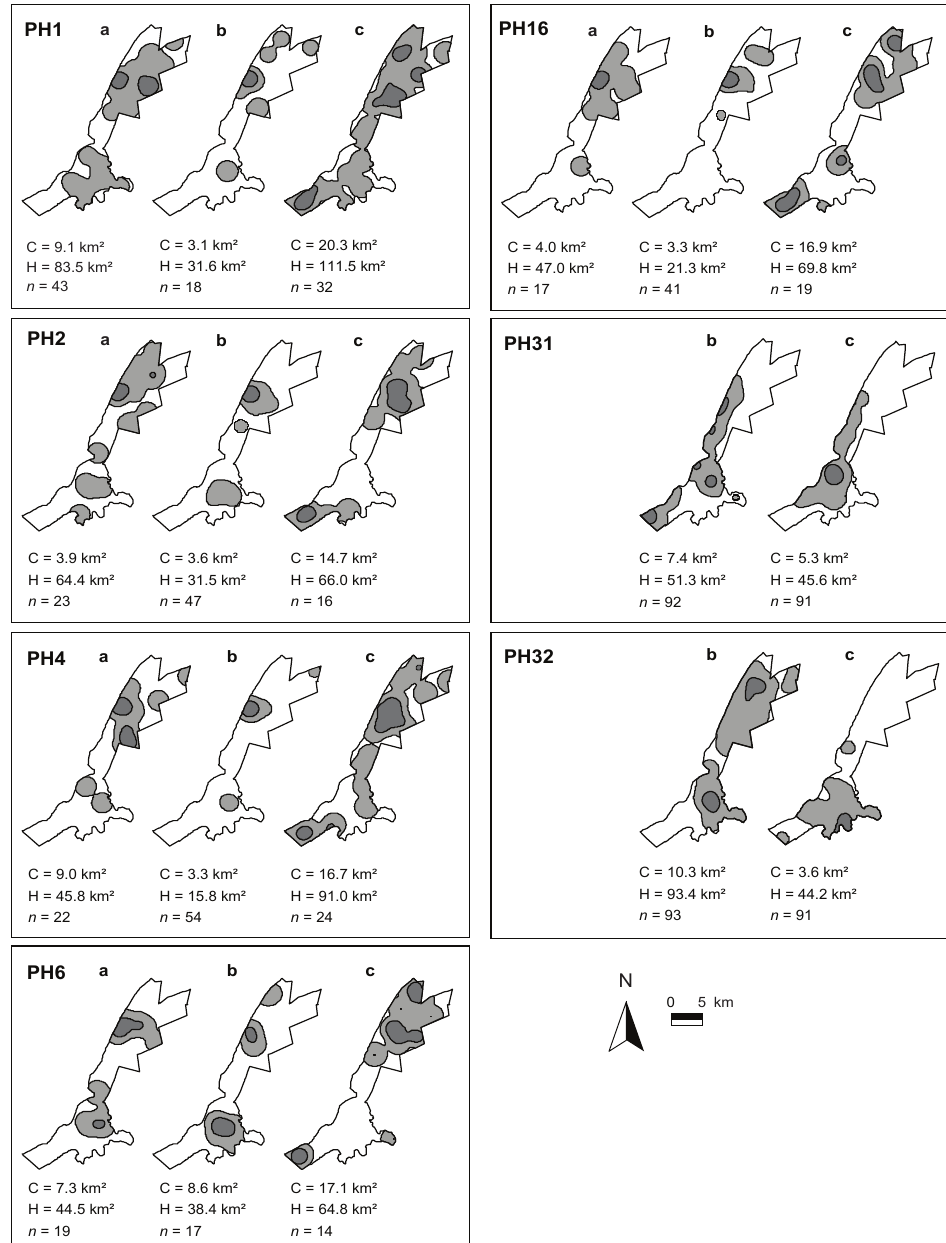
Fig. 2. Ranging of bull elephants on Phinda: The effect of the introduction of older elephant bulls on the ranging behaviour of younger, resident bulls. Three maps are shown for each resident bull and two for the introduced bulls: (a) three months before the introduction of the new bulls, (b) three months directly after introduction, (c) three month period 9-12 months after introduction. C = Core ranges (50 % kernel - dark grey shading) and H = home ranges (95 % kernel - light grey shading). n = number of sightings used to calculate ranges for that period.